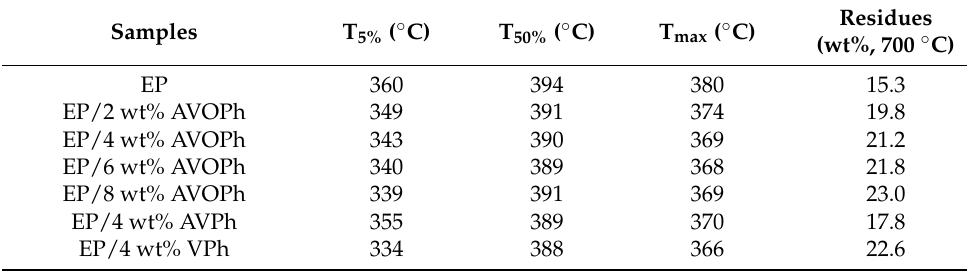
Figure 2. TGA curves of pure EP and its composites. Table 1. TGA data of pure EP and its composites.